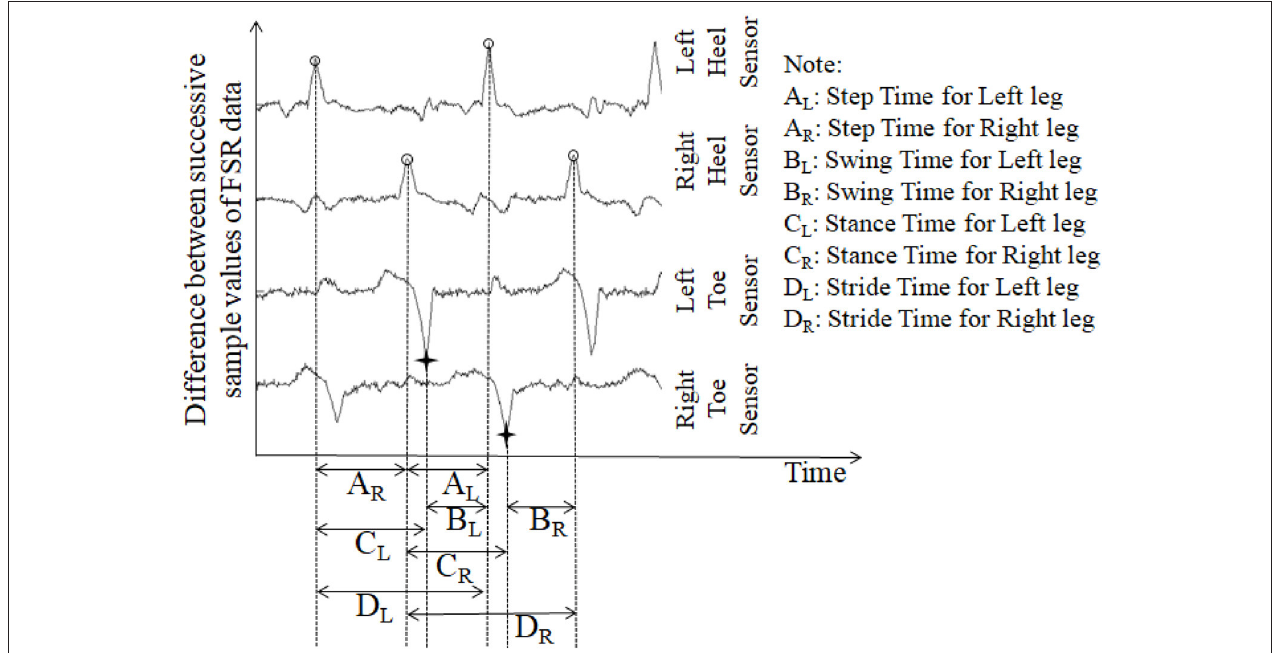
FIGURE 4 | The successive difference signal derived from different FSR outputs. “o” represents heel strike (foot strike) events; “ + ” represents toe off (foot off)